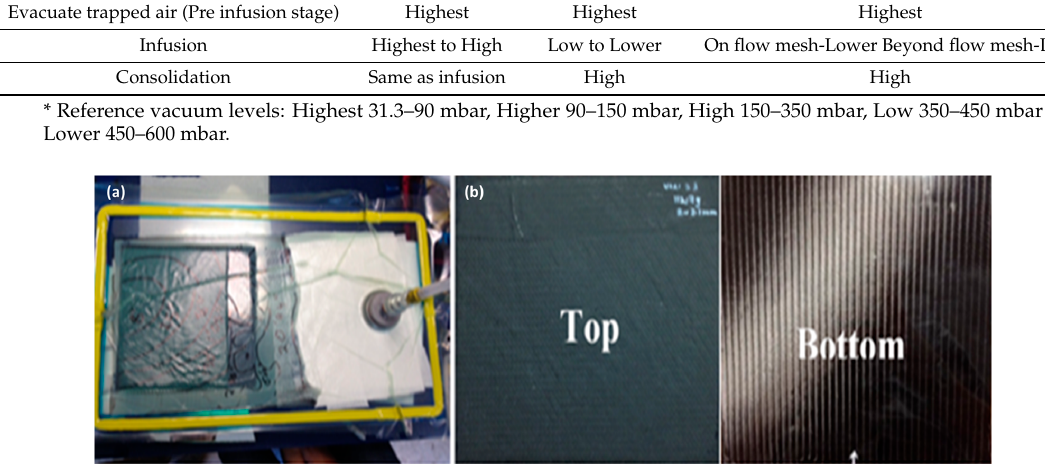
Figure 8. Infusion with optimised process parameters ( a ) set-up with reduced flow mesh length and three-stage vacuum level using glass mould; and ( b ) fully impregnated top and bottom sides of the panel.